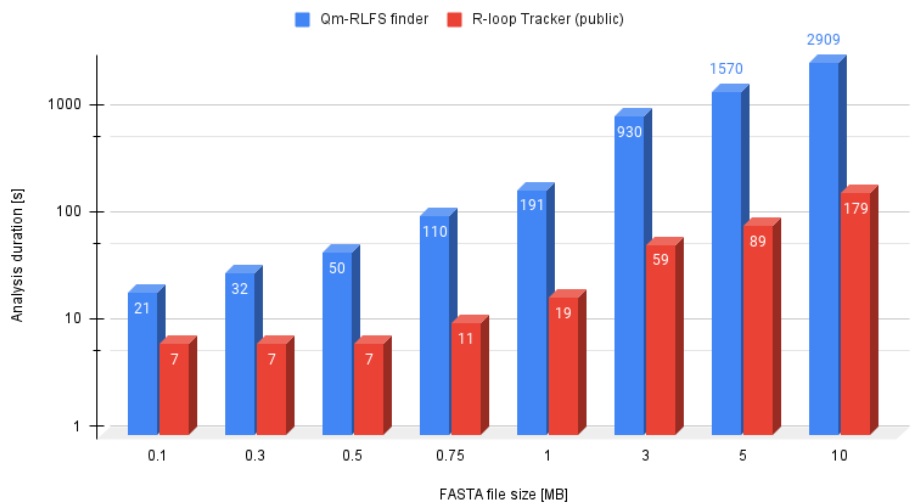
Figure 3. R-loop tracker web server effectivity compared to that of the QmRLFS finder tool. As we can see in the figure, R-loop tracker was faster compared to QmRLFS finder.